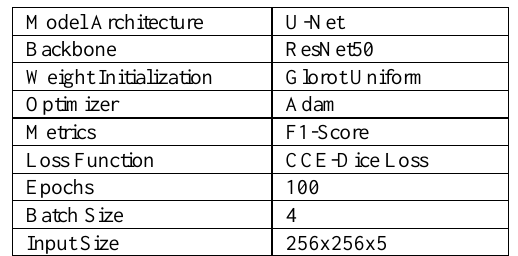
Table 3 . The model configurations used in the